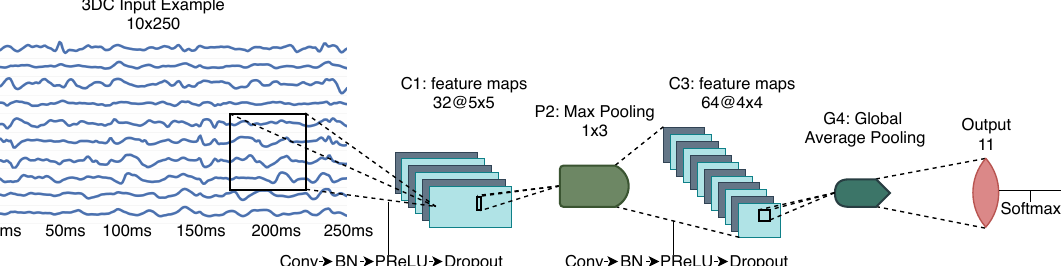
Figure 9. The raw ConvNet architecture employing 34,667 parameters. In this figure, Conv refers to Convolution and BN refers to Batch Normalization. While the input represented in this figure is that of the 3DC, the architecture remains the same for all considered systems.